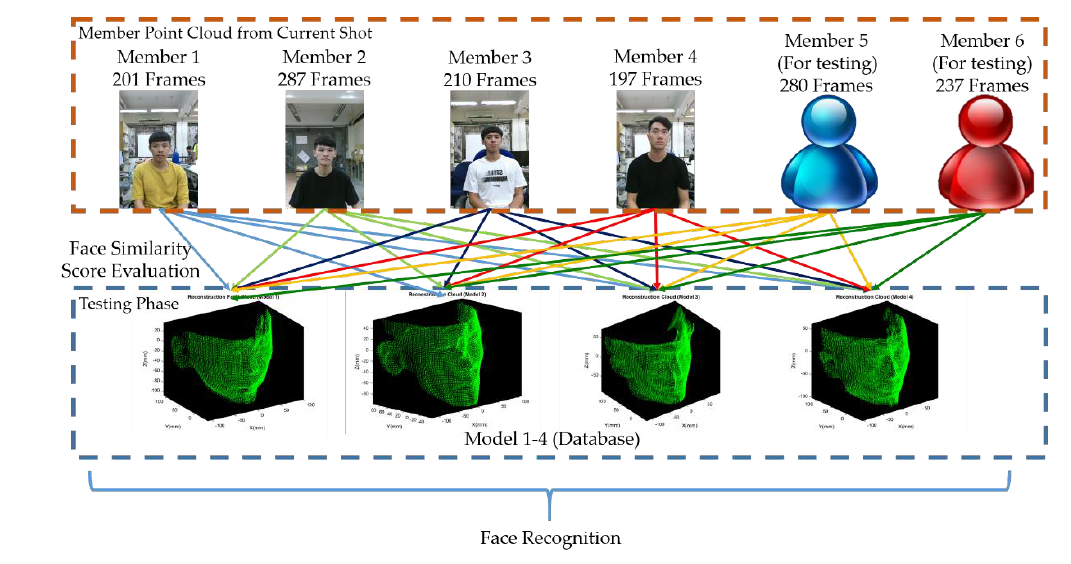
Figure 21. Schematic illustration of 3D face recognition.